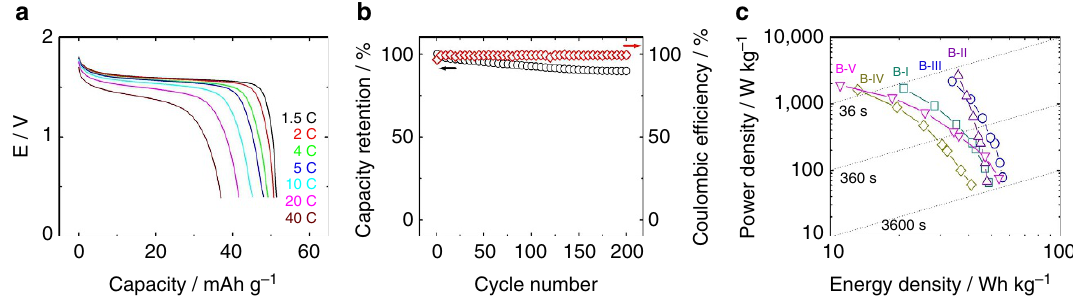
Figure 4 | Rate capability and cycle life of mixed-ion batteries. ( a ) Rate capability of B-III battery. ( b ) Long-term cycling performance for B-III battery at a rate of 1.5C. ( c ) A Ragone plot of B-I, B-II, B-III, B-IV and B-V.